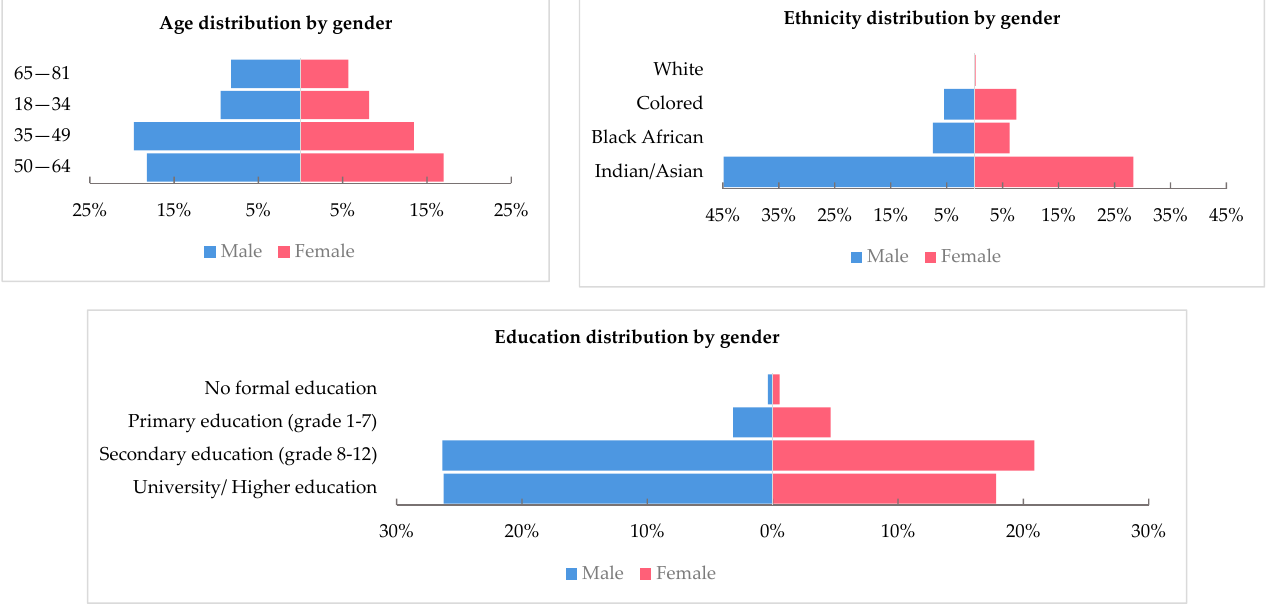
Figure 1. Age, ethnicity and level of education distribution by gender among the study population.